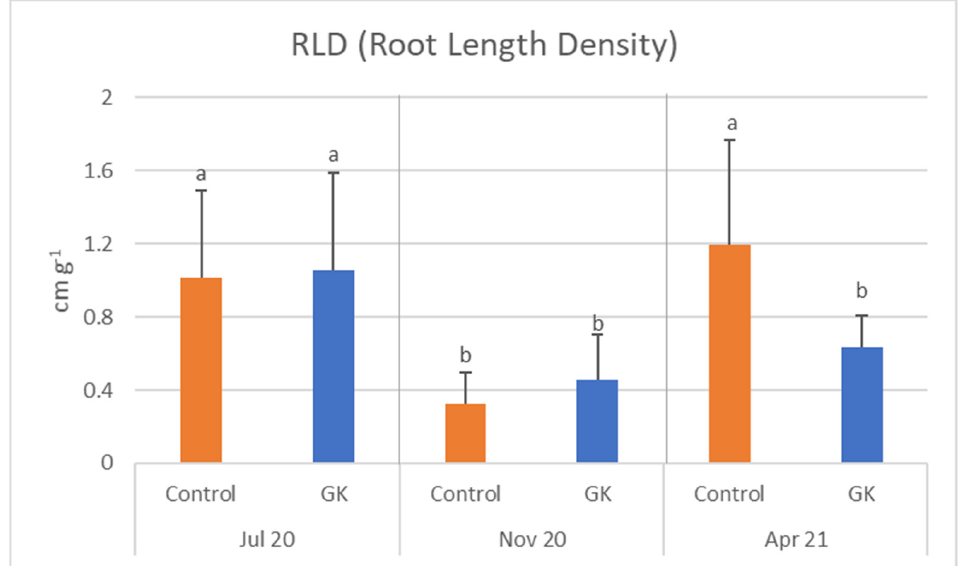
Figure 8. Root length density (RLD, measured as total root length soil weight − 1 ) in the three sampling dates. Since no significant differences were found between the Grass Killer (GK) 1.2, 1.7 and 2.6 km per hour working speed treatments, data were analysed together. Control = hoeing machine. Data are means ± standard deviation, different letters indicate significative differences between treatments and sampling dates for HSD Tukey–Kramer HSD test ( p < 0.05).